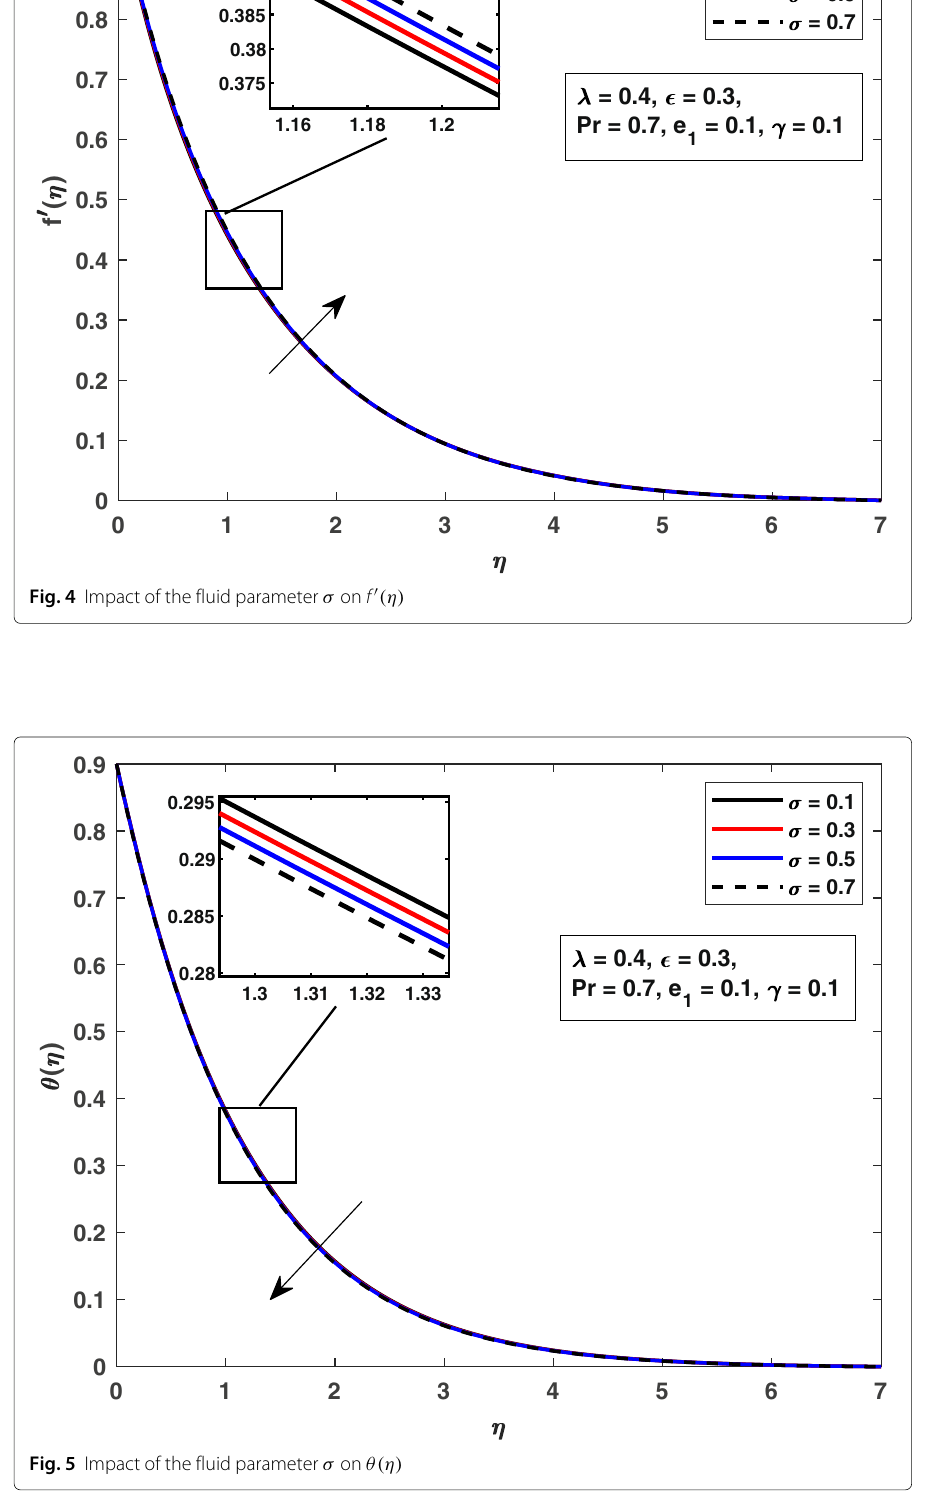
Fig. 5 Impact of the fluid parameter σ on